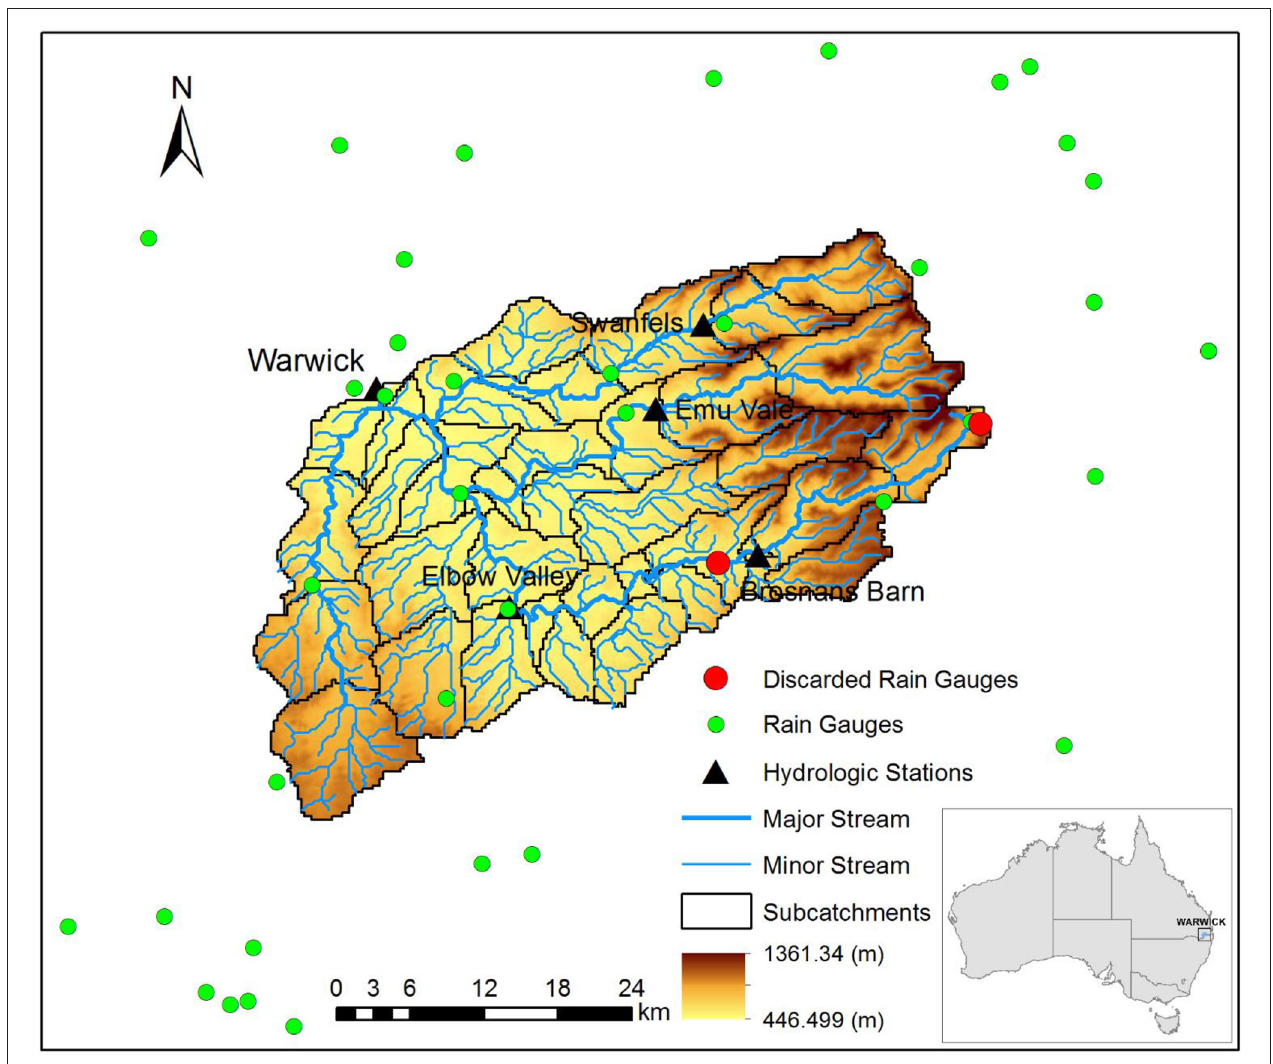
FIGURE 1 | The study catchment and location of